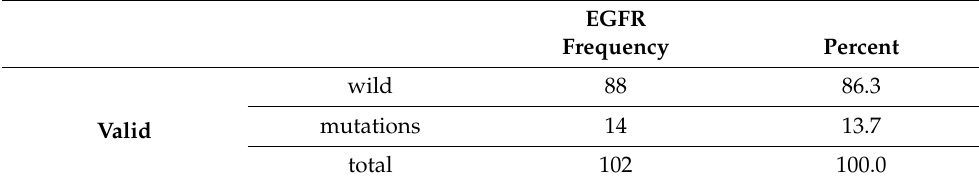
Table 2. Percentage of adenocarcinoma